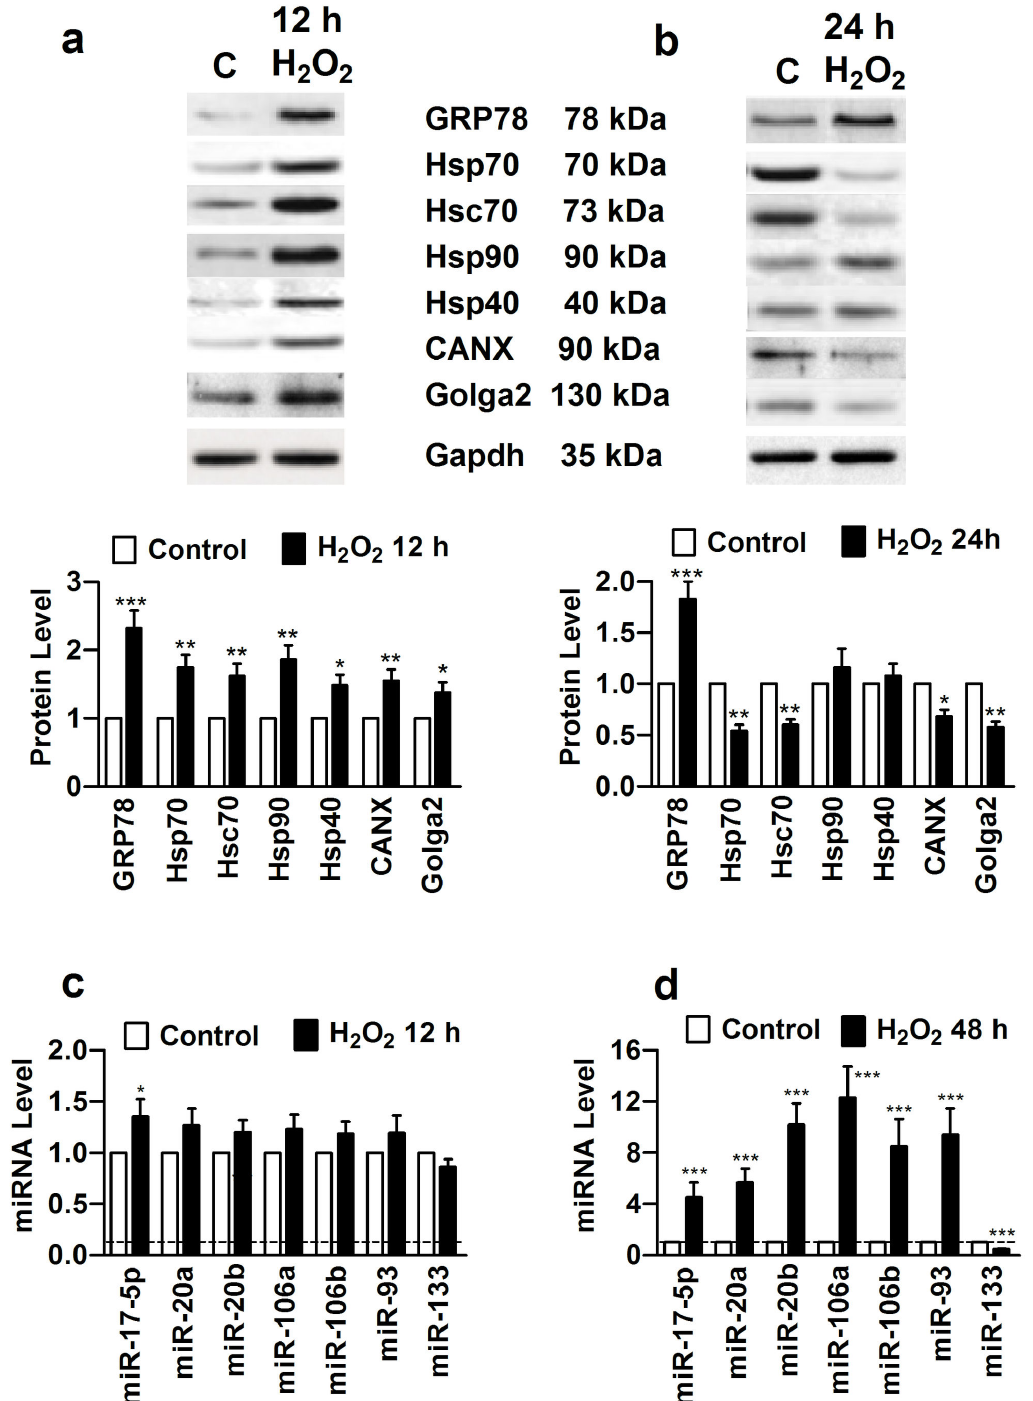
Figure 2. Reciprocal changes of expression between miR-17-5p and ER stress-related chaperones after chronic oxidative stress in h-ERG-expressing HEK293 cells. Cells were incubated with H O (40 nmol/L) for at 12 h and 48 h. (a) & (b) Expression 2 2 of ER stress-related chaperones at 12 and 48 h after oxidative stress, respectively, by Western blot analysis. * P <0.05, ** P <0.01 & *** P <0.001 H O vs Control; n=6; (c) & (d) Expression of miR-17-5p seed family miRNAs, at 12 and 48 h after oxidative stress, 2 2 respectively, using real-time RT-PCR. *** P <0.001 H O vs Control; n=6. Similar results were observed in neonatal rat ventricular 2 2 myocytes (Figure S7 in File S1). doi: 10.1371/journal.pone.0084984.g002 PLOS ONE |